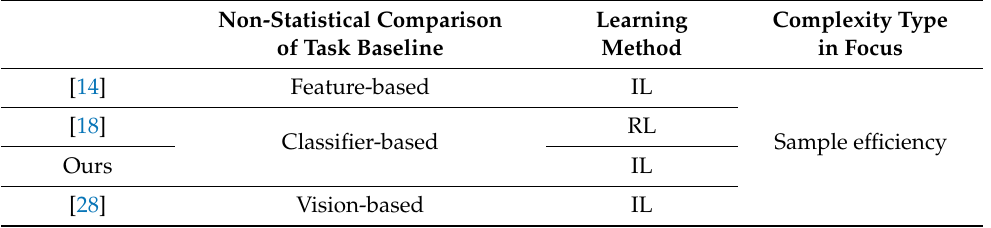
Table 6. Difference between our proposed method and other based techniques in terms of comparison